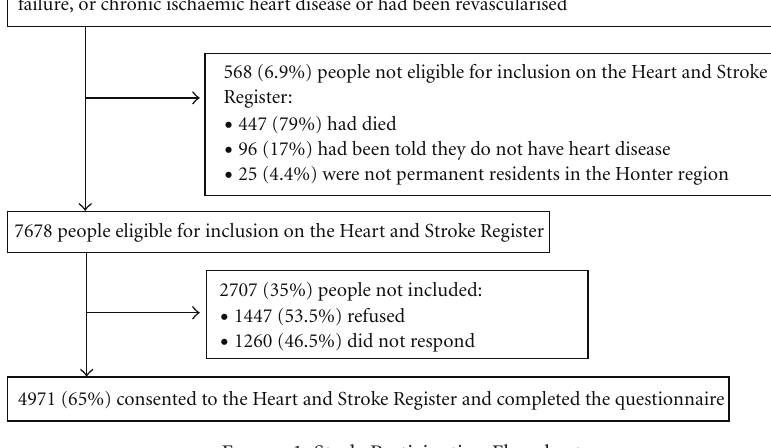
Figure 1: Study Participation Flowchart.